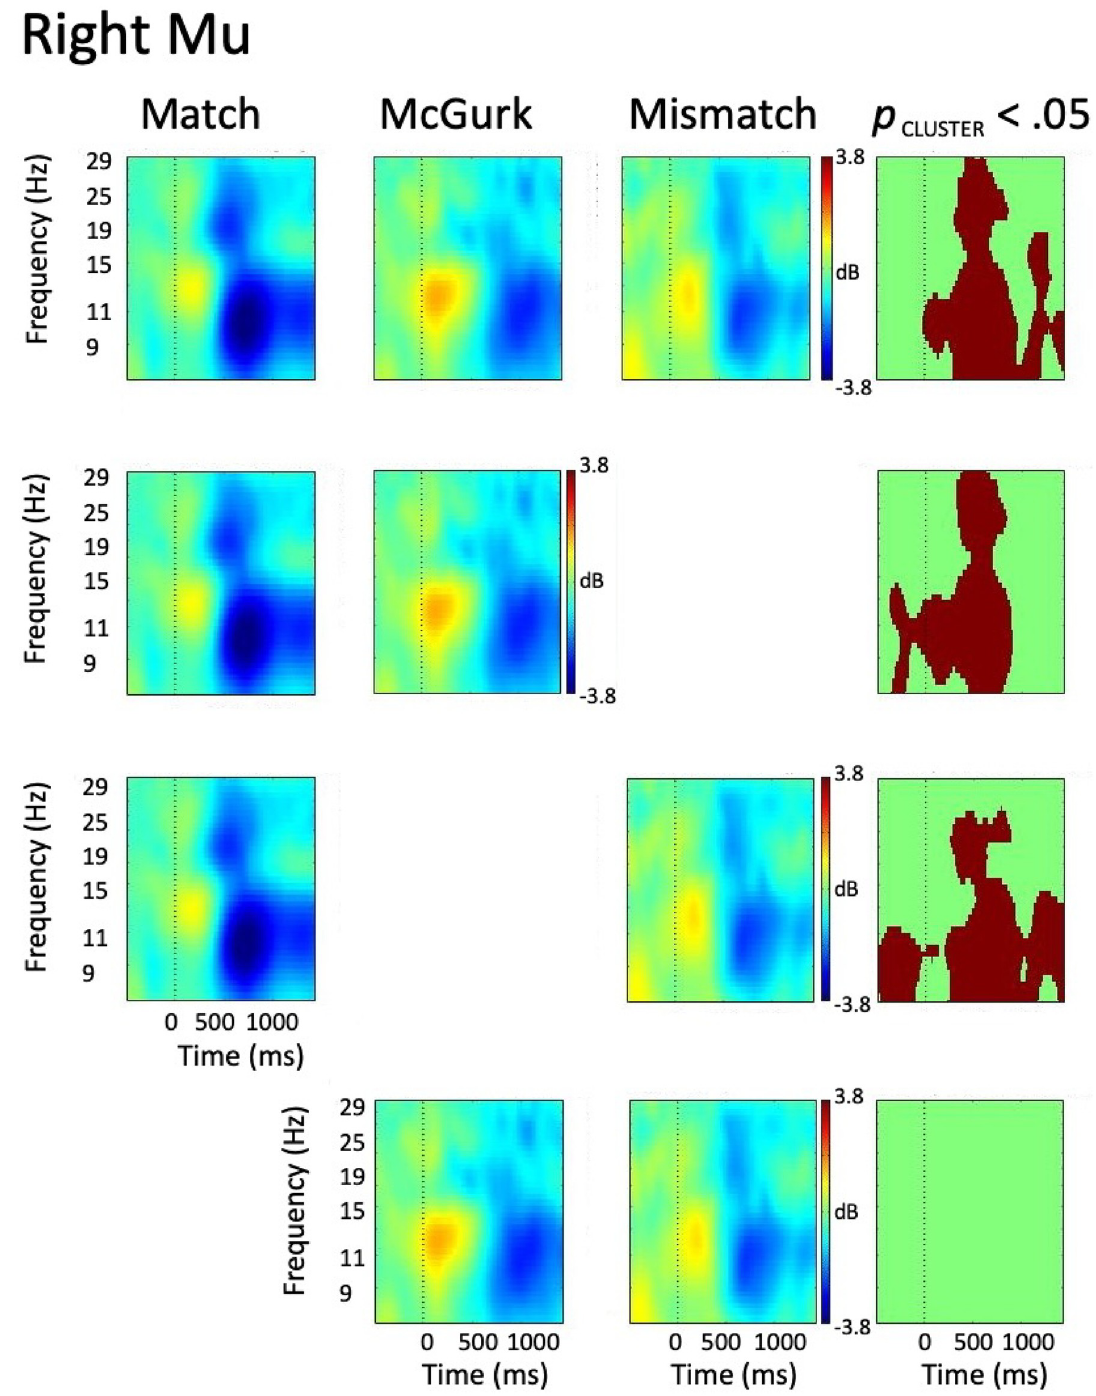
Fig 5. ERSP data from right hemisphere mu cluster. The first three columns represent data from Match, McGurk, and Mismatch conditions, with the right-most column showing time-frequency voxels significant at p < .05 (cluster corrected). The top row shows the results of the omnibus tests, while the lower rows show the results of the post-hoc tests.